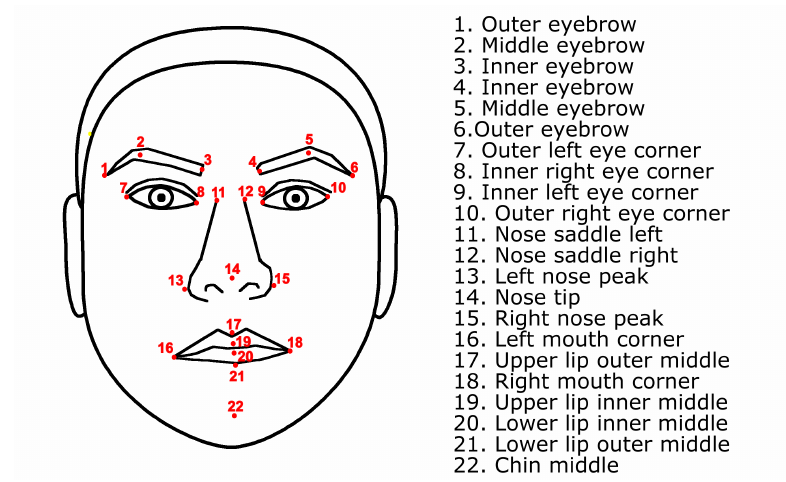
Figure 5. Twenty-two landmarks used in feature extraction. Table 4. 3D and 2D original